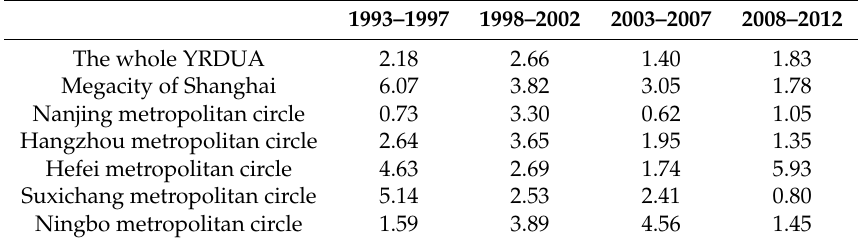
Table 3. Elastic coefficients of urban expansion-population growth for the YRDUA for